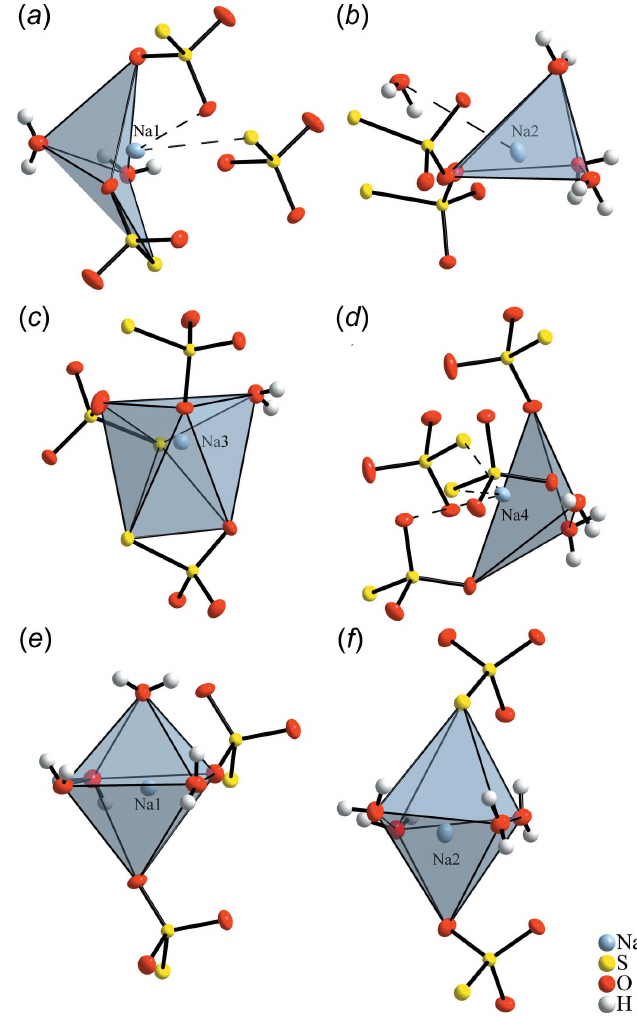
Figure 3 Coordination polyhedra around the Na + cations in Na 2 S 2 O 3 (cid:2) 2H 2 O ( a – d ) and in Na 2 S 2 O 3 (cid:2) 5H 2 O ( e – f ). Anisotropic displacement ellipsoids of non- H atoms are drawn with 80% probability, weakly or non-coordinating distances above 2.55 A˚ for Na—O and 3.18 A˚ for Na—S as dashed lines.